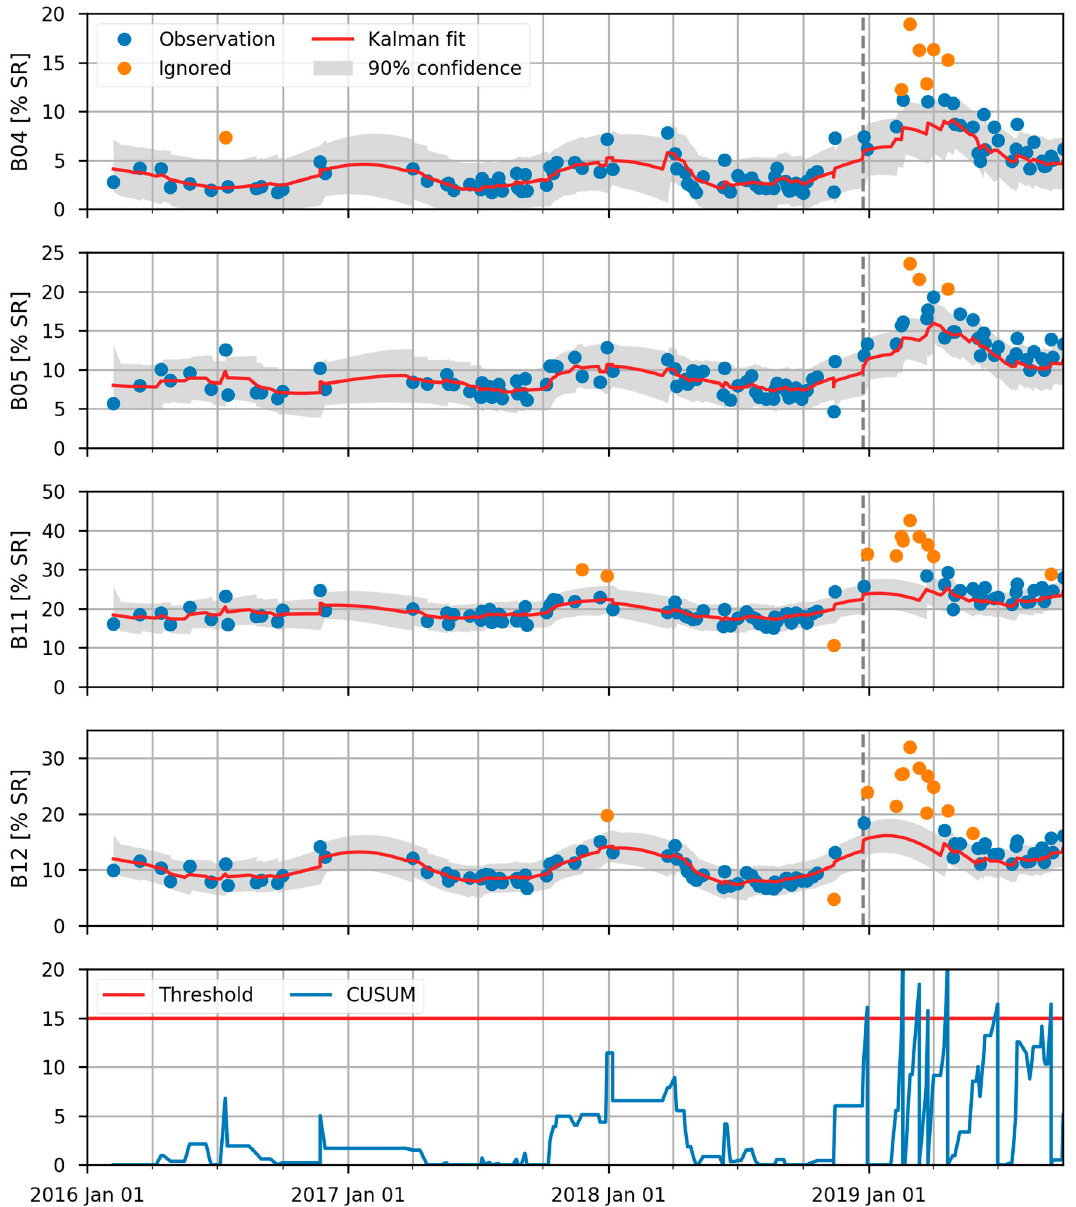
Figure 4. Example of the time series model for a deciduous forest pixel at the Austrian test site, where a forest change occurred at the end of 2018. The plots show the surface reflectance of Sentinel-2 bands 4, 5, 11, and 12. The vertical dashed line marks the date on which the change is visible for the first time in the S-2 image time series. The plot at the bottom shows the cumulative sum control chart (CUSUM) used for detecting the change event (coordinates: X 559045 m, Y 5235095 m, in EPSG